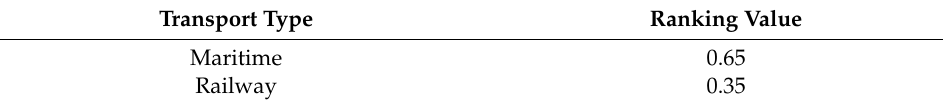
Table 6. Ranking vector.